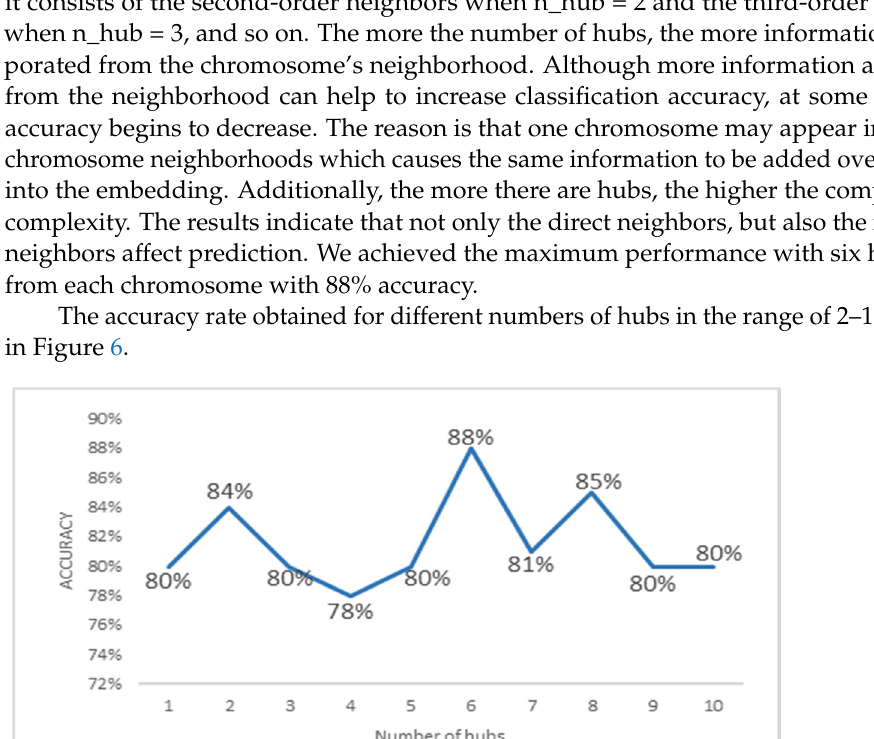
11 of 15 Figure 5. Performance of GraphChrom, vanilla neural network, SVM, and kNN based on inter-, intra-, and integrated chromosomal rearrangement endpoints.